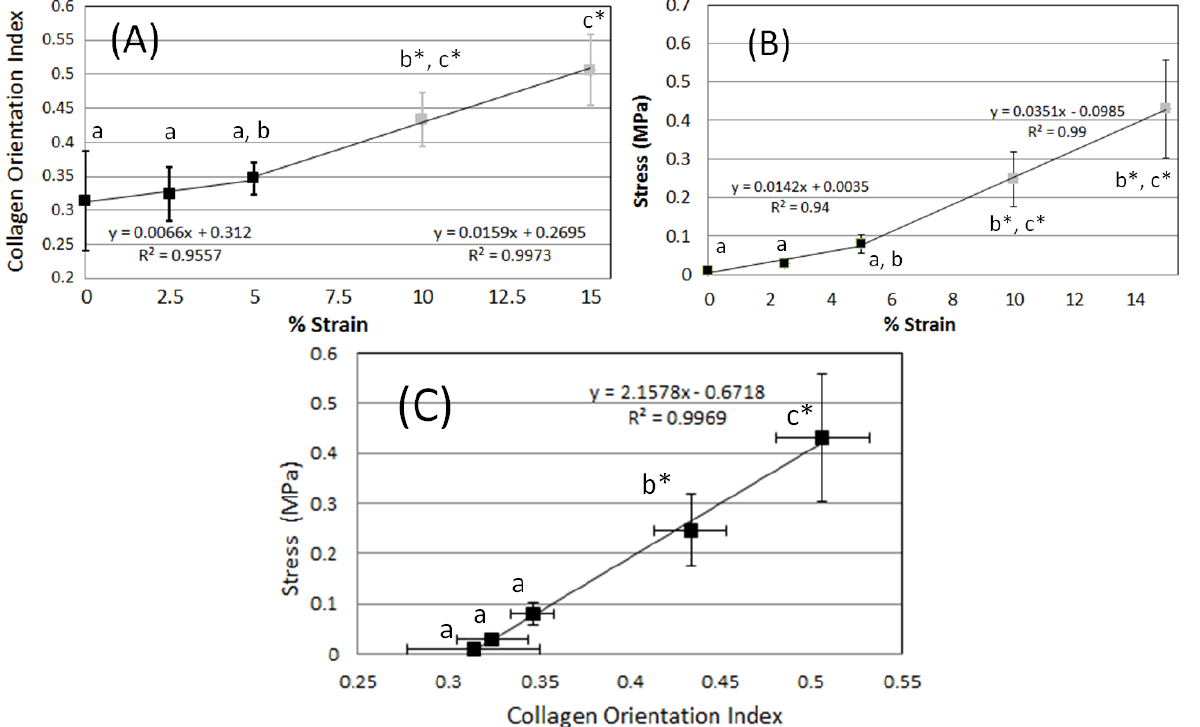
Figure 3. The collagen orientation index (COI) and stress plotted as functions of induced strain. ( a ) The COI plotted as a function of induced strain. Linear regression is performed on two different regions above and below 5% strain; ( b ) Stress vs. strain demonstrates similar properties to COI vs. strain; ( c ) Stress (used to induce strain) vs. COI demonstrates high correlation. Error bars indicate standard deviation and n = 4. Similar letters indicate that the groups are statistically similar. The symbol * indicates power >